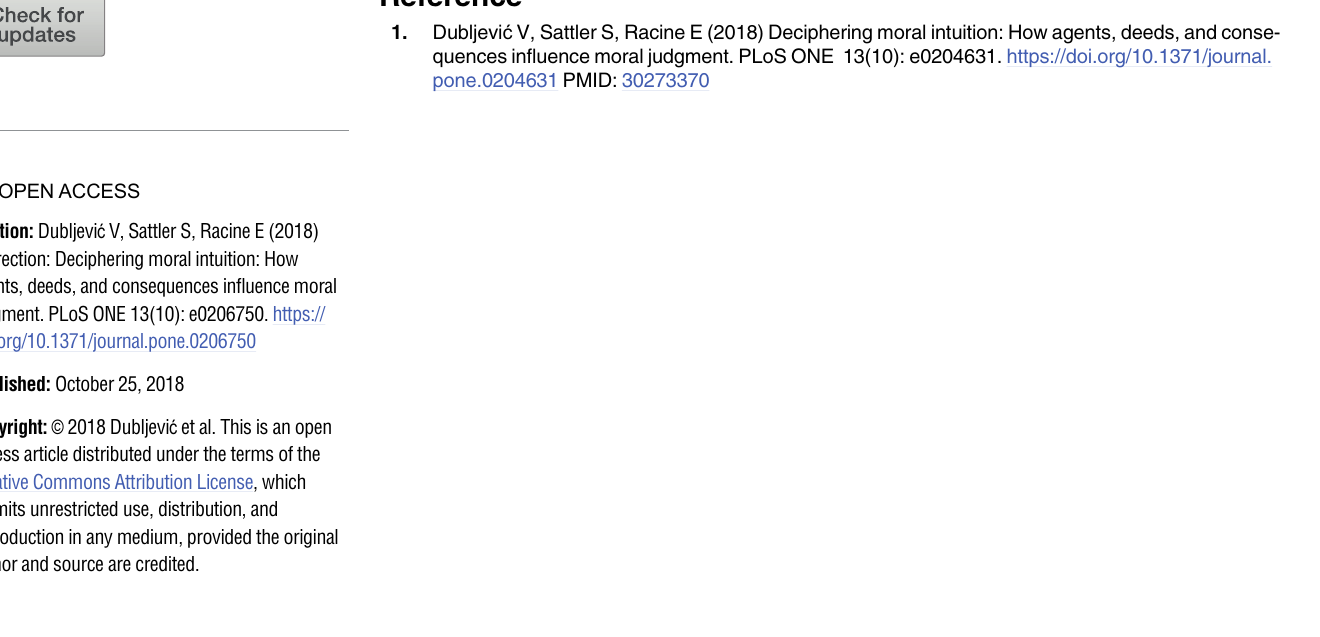
S1 Table. T-tests for the manipulation checks for low- and high-stakes vignettes. (DOCX) S2 Table. Correlation coefficients between self-identifications with moral theories and Preferences for Precepts Implied in Moral Theories (PPIMT). S3 Table. Summary of the findings of the